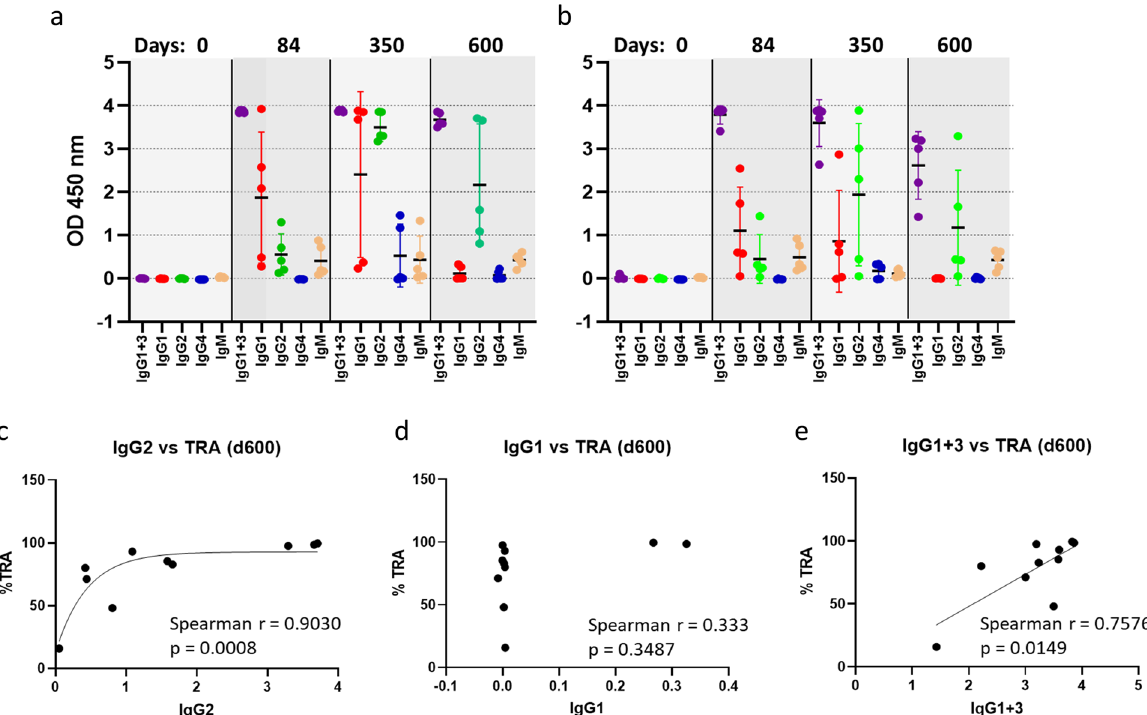
Fig. 6 IgG subclass distribution in the immune sera. IgG subclasses (IgG1 + 3, IgG1, IgG2, IgG4) and IgM antibody levels in sera from Rhesus vaccinated with high dose ( a ) and low dose ( b ) of the Pfs230D1-EPA conjugate formulated with ALFQ assayed at different time points (days 0, 84, 350 and 600) during the study. Error bars represent the mean and standard deviation. Correlation between the functional activity (%TRA) of sera from day 600 and levels of IgG subclasses IgG2 ( c ), IgG1 ( d ) and IgG1 + 3 ( e ). Immune sera from each animal were analyzed by ELISA using the Rhesus speci fi c monoclonal antibody isotype controls listed in Supplementary Table